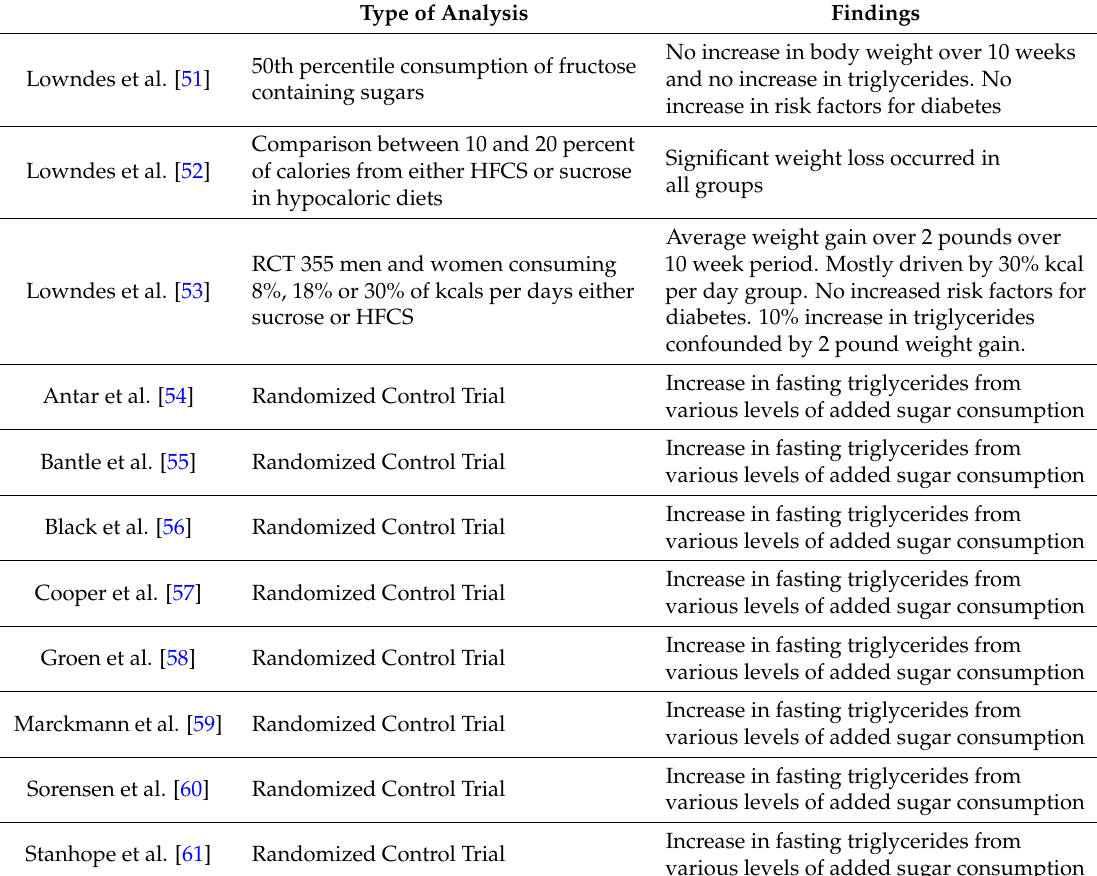
Table 1. Randomized Control Trials